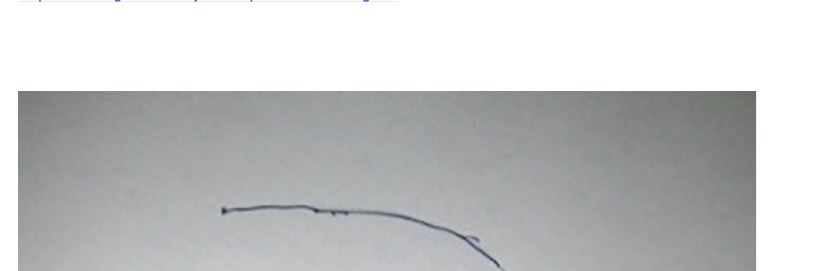
Fig 2. Alan, T1, Nasopharyngeal cancer. Drawing shows palpable lump in neck.